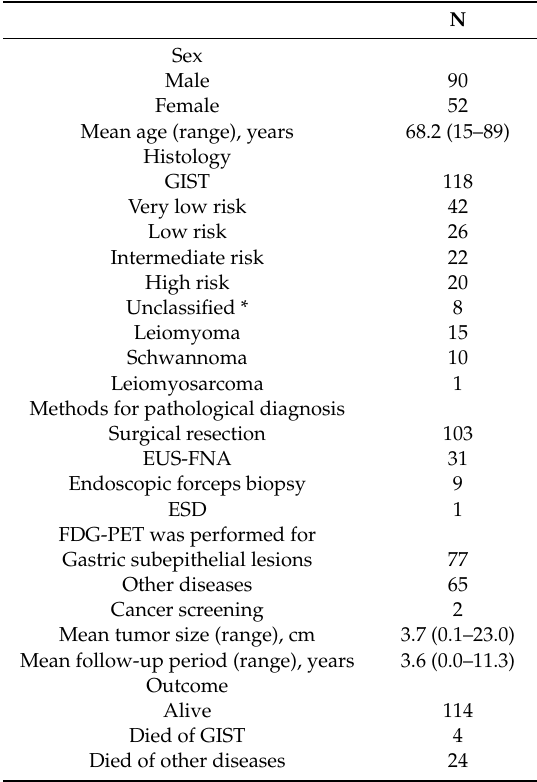
Table 1. Clinical characteristics of the study patients.